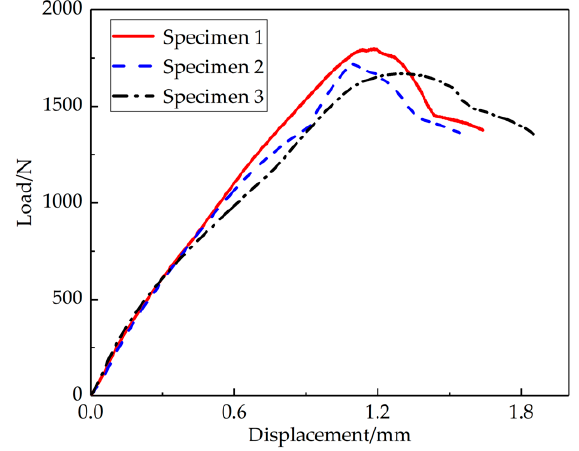
Figure 6. The L-D curve of the SPT of the three joints.